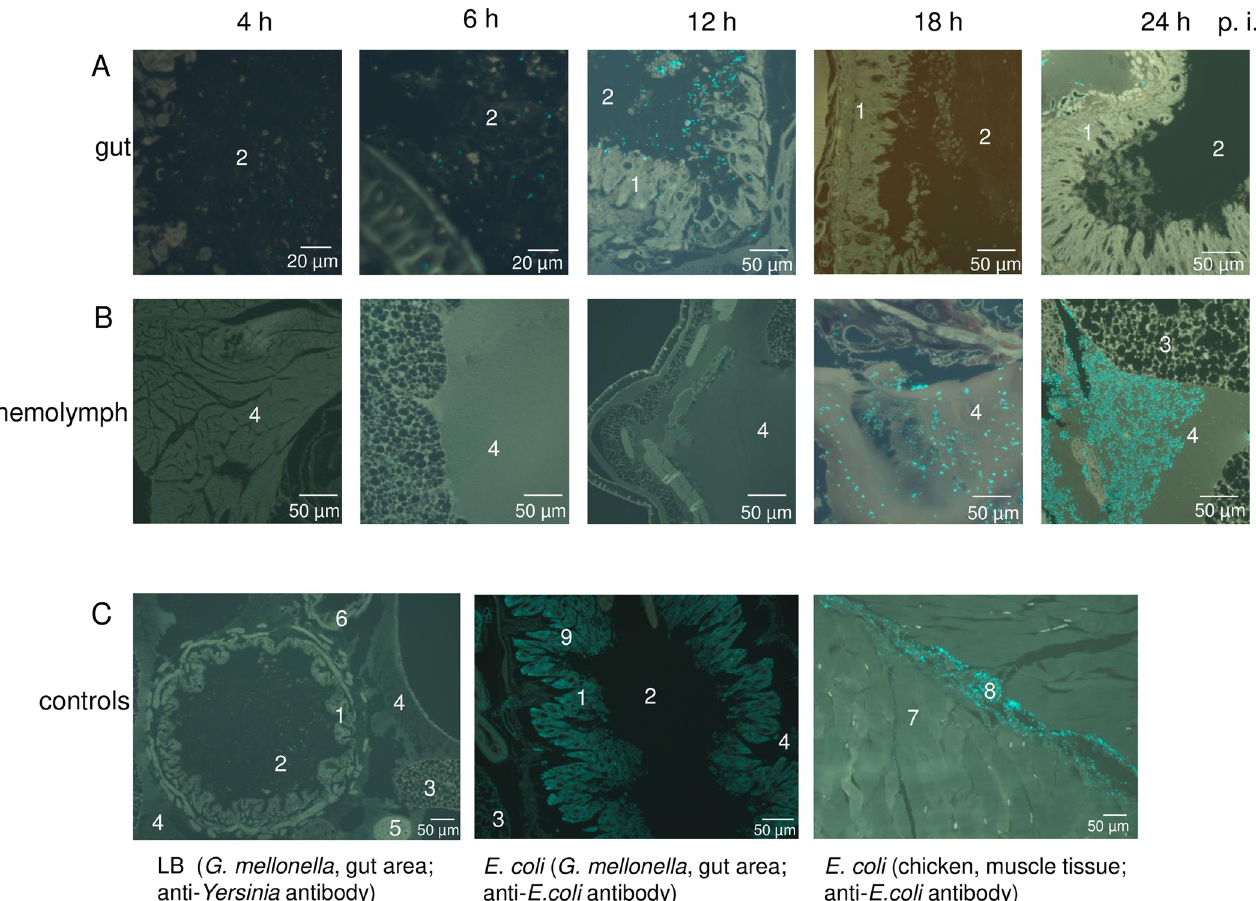
Fig 5. Time course of G . mellonella infection by Y . enterocolitica W22703. The tissue sections monitored by fluorescence microscopy show antibody-stained Y . enterocolitica cells in the (A) gut or (B) hemolymph of G . mellonella 4 h, 6 h, 12 h, 18 h, and 24 h after infection. (C) The controls depict the gut area of G . mellonella that were fed with LB (left) or infected with E . coli (middle) 24 h ago. The tissue sections were stained with a Yersinia -specific or an E . coli -specific antibody. Functionality of the anti- E . coli antibody was demonstrated by the application of E . coli into muscle tissue of chicken (right). Cyan-coloured areas in the gut area of G . mellonella are unspecific bonds of the anti- E . coli antibody. Representative preparations are shown; the scale is indicated. 1 = intestinal epithelium, 2 = intestinal lumen, 3 = fat tissue, 4 = hemolymph, 5 = appendix, 6 = Malpighian vessels, 7 = muscle cells, 8 = E . coli , 9 = antibody cross